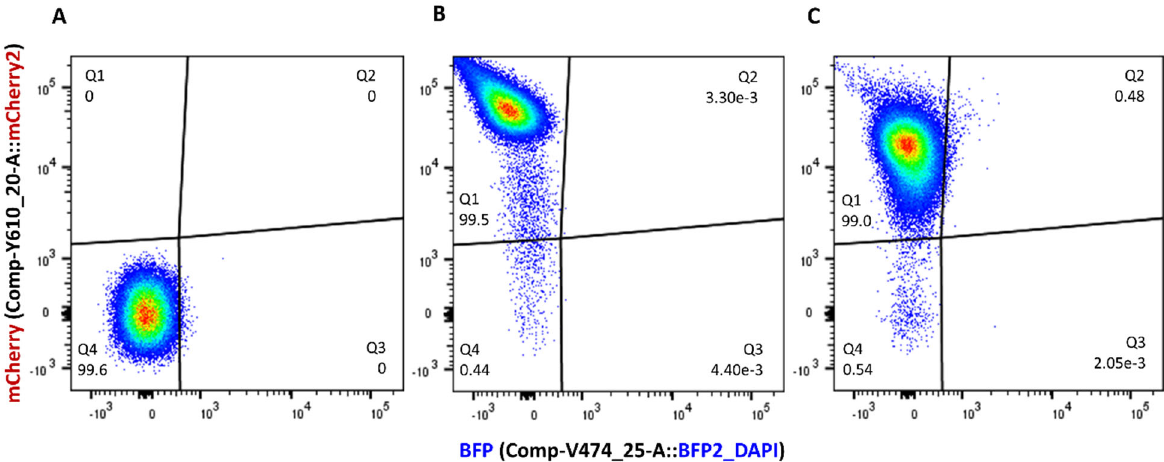
Figure 1. Flow cytometry detection of the E. coli J53Az + p_mCherry-stable recipient strain displayed on bivariate plots of red versus blue fluorescence with spectral compensation. In contrast to the non-fluorescent J53Az negative control strain ( A ), the J53Az + p_mCherry-stable single-color, positive control strain recovered from filter mating incubation conditions at time points 0 h ( B ) and 6 h ( C ) emitted strong red fluorescence signals that clearly distinguished them from the negative control strain. Regions Q1 and Q4 on the red (mCherry2) versus blue (BFP) fluorescence bivariate plots were designated mCherry + and mCherry − populations, respectively.